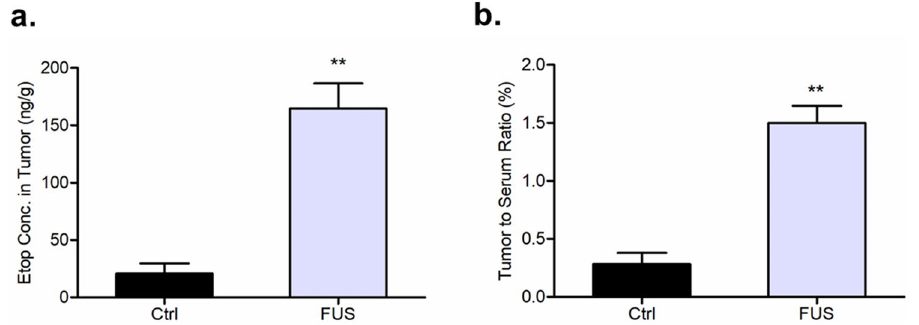
Figure 6. LC–MS/MS measurements of etoposide delivery. ( a ) Concentration of etoposide in brain tumors with and without sonication. ( b ) The tumor-to-serum ratios of etoposide concentration is more than fivefold greater in the treatment group ( p <